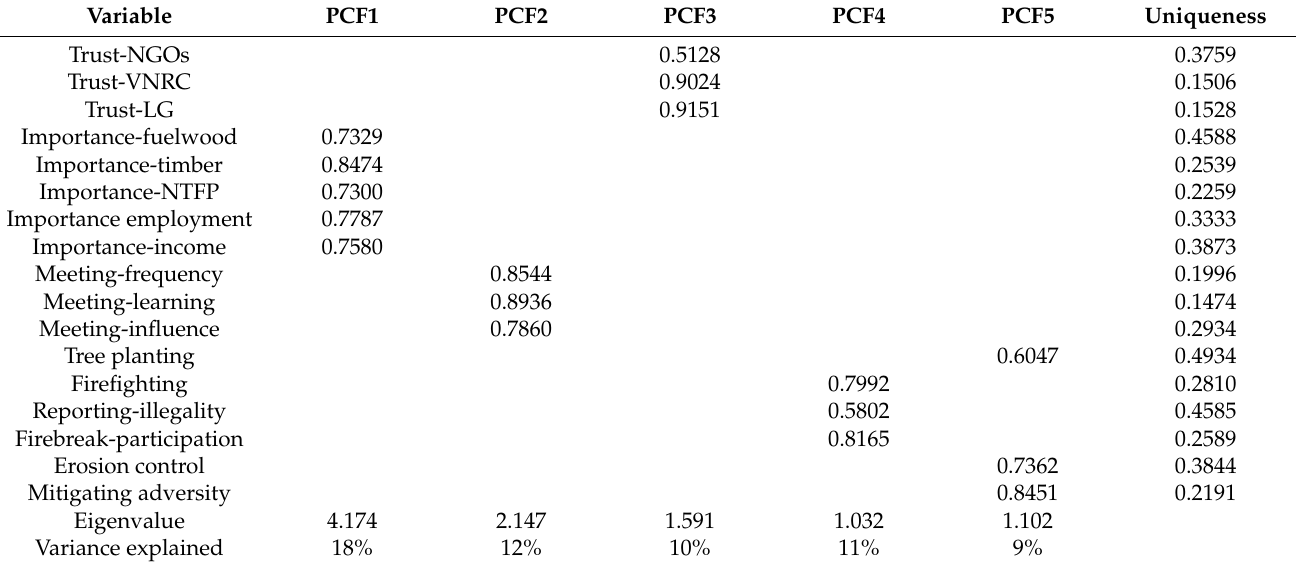
Table 3. Principal Component Factors Summarized by the Factor Analysis